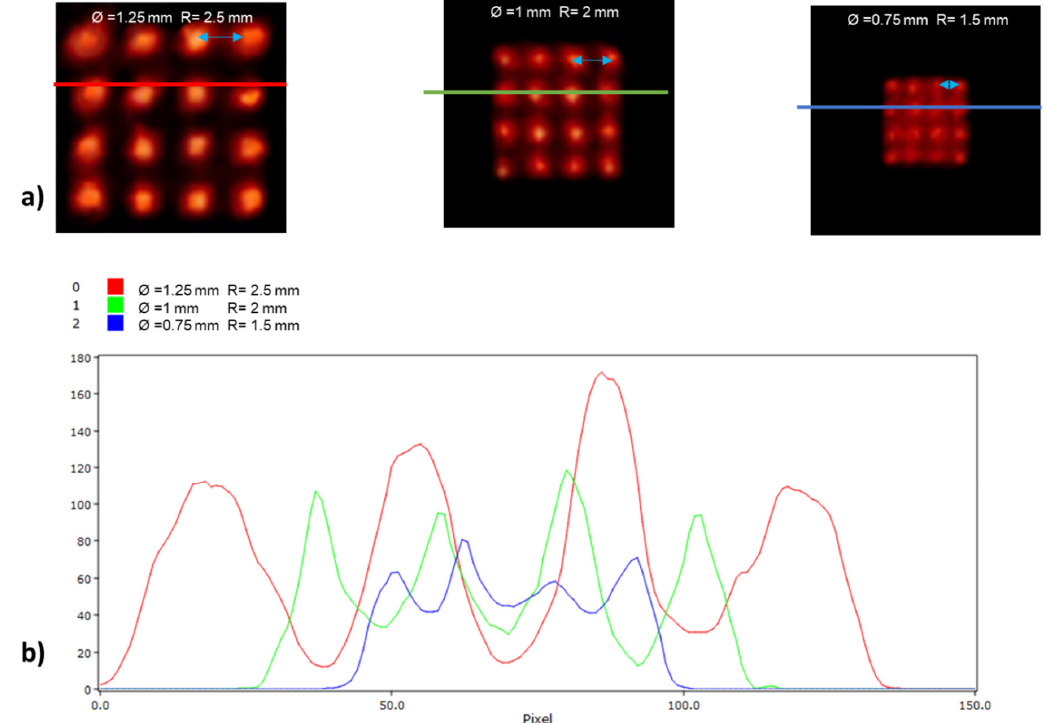
Figure 8. ( a ) Planar images and ( b ) line profiles of a grid containing 16 spherical sources with different diameters (from left to right: 1.25, 1 and 0.75 mm) and distances (from left to right: 2.5, 2, and 1.5 mm) for detector modules using the Anger logic positioning algorithm.